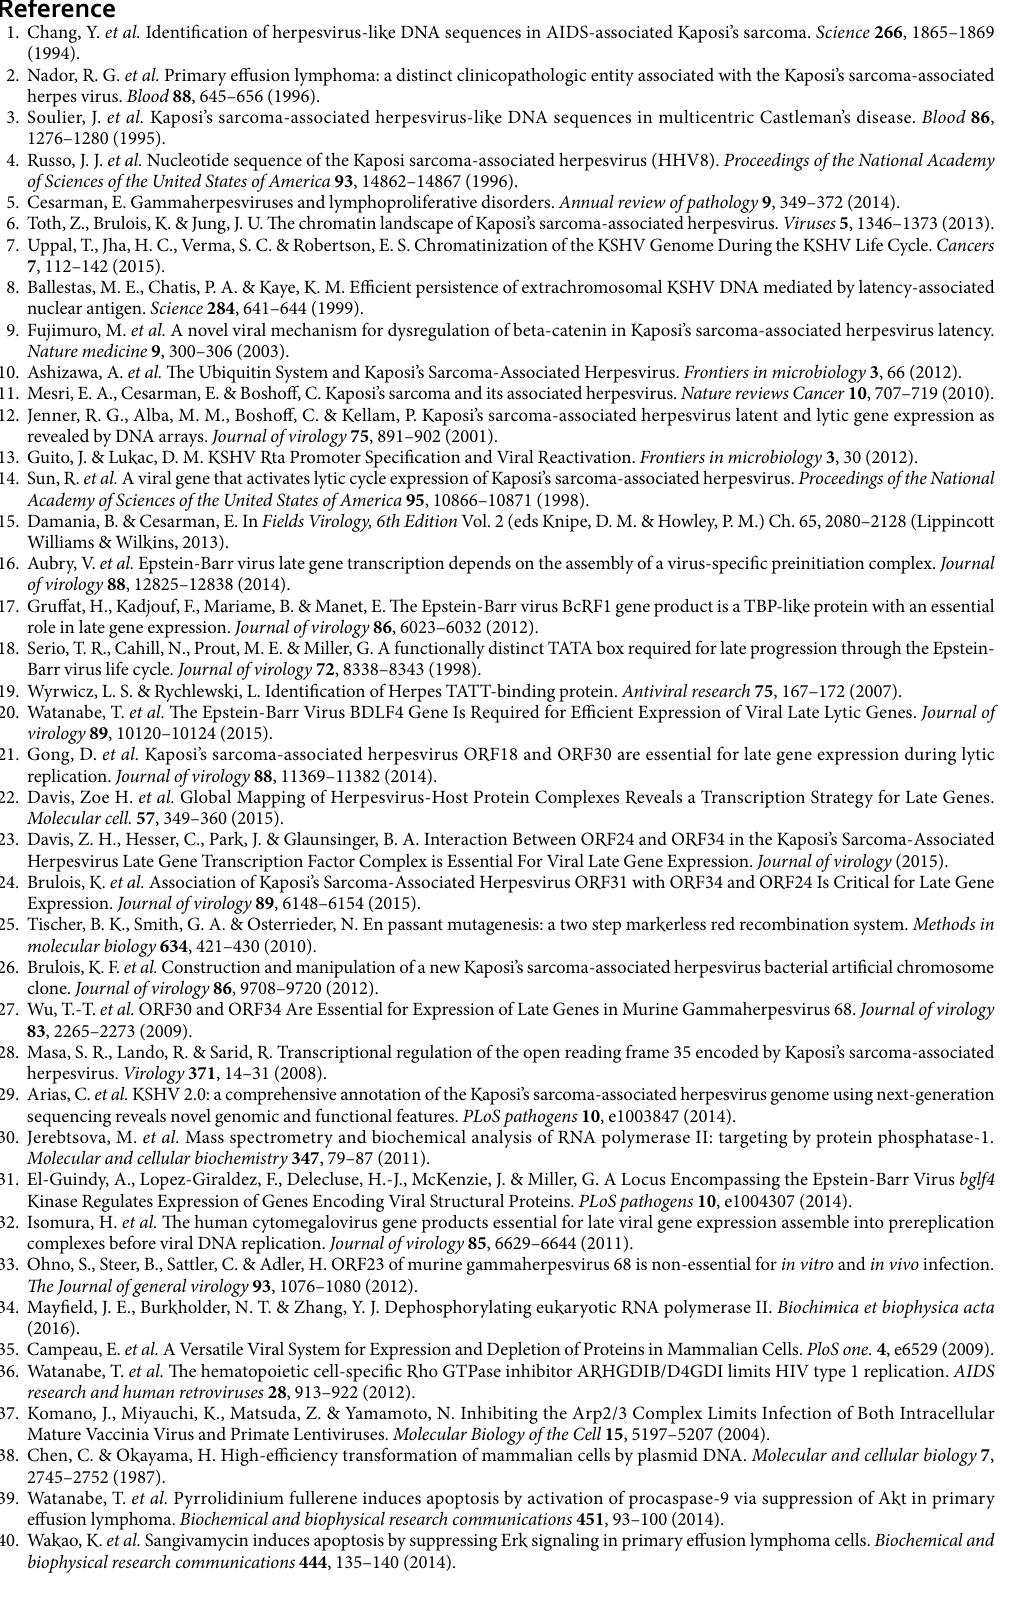
immunoprecipitated viral DNA were normalized to total input DNA. The sequences of qPCR primer sets for each ORF transcriptional start site of are noted in Supplementary Table S1. Statistics. The two-tailed student’s t -test was used to indicate the differences between the groups. P values are shown in each